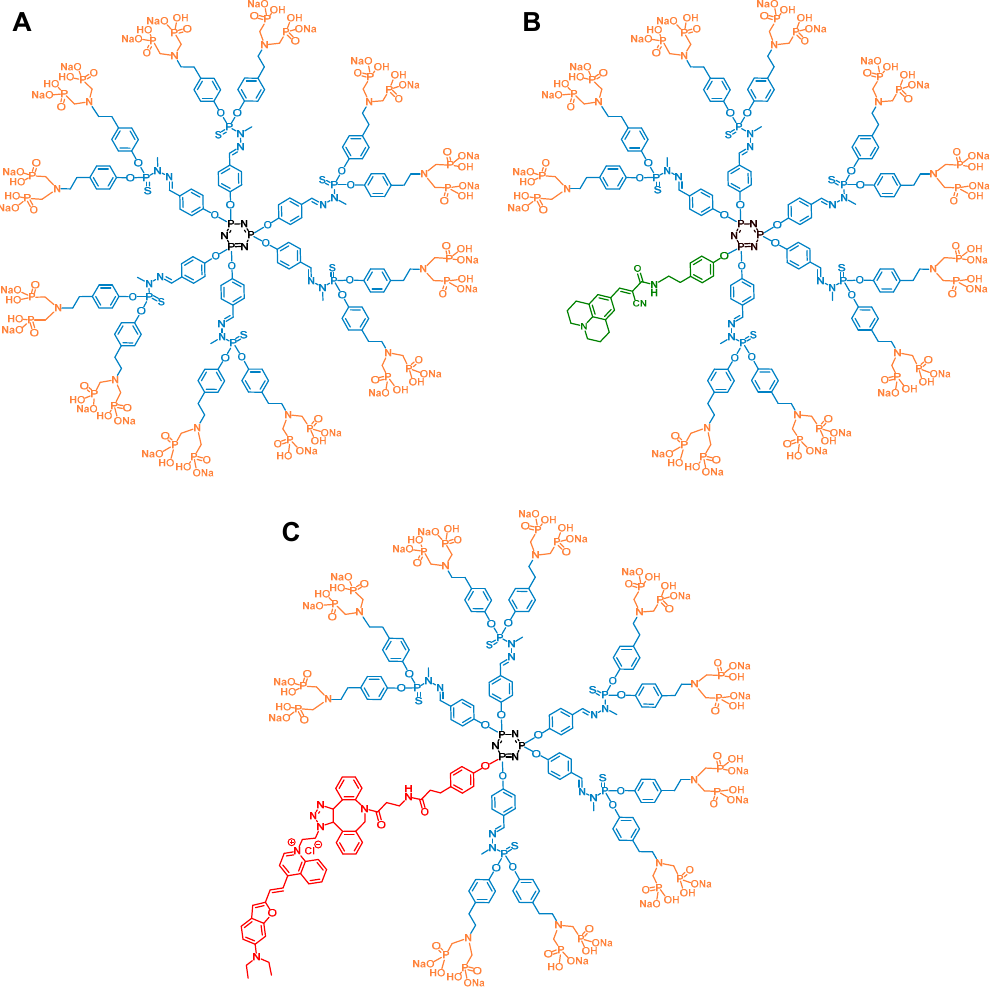
Figure 1. Structure of the three dendrimers used in this study. The cyclotriphosphazene core (N 3 P 3 ) is in black, the poly(phosphorhydrazone) (PPH) branches (including the point of divergence) are in blue. The tyramine-based (in blue) azabisphosphonate (ABP) surface groups are in orange. ( A ) The ABP dendrimer. ( B ) The ABP-Julolidine dendrimer. ( C ) The ABP-near infrared reflectance (NIR) dendrimer.